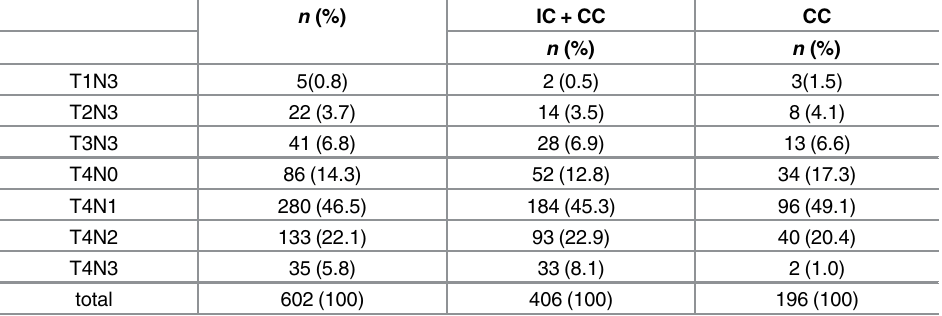
Table 2. T and N category distributions for the 602 patients with stage IVa-b nasopharyngeal carci- noma stratified by treatment